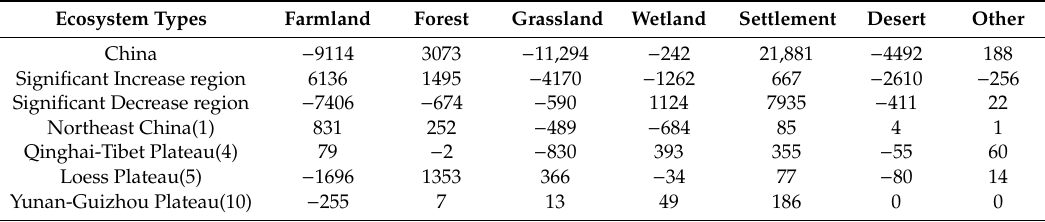
Figure 4. Linear trends (LT) and correlations of annual temperature (AT), precipitation (AP) and WP in China from 2000 to 2013. Methods for Classifying of the significance of linear trends of AT ( a ) and AP ( b ) are the same as in Figure 3. The significance of correlations between AT ( c ) or AP ( d ) and annual WP are classified into five categories, methods are given in the Section 2.3. Table 2. The area of di ff erent typical variation regions of WP from 2010 to 2010 (km 2 ). Ecosystem Types Farmland Forest Grassland